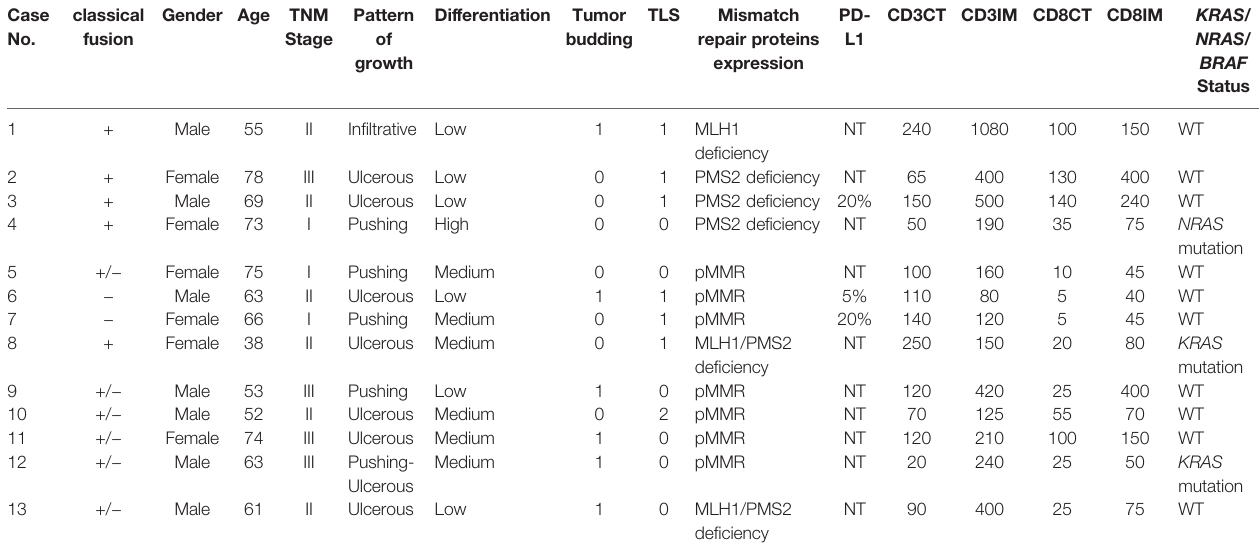
TABLE 3 | Clinical, pathological, immunological and molecular characteristics of 13 NTRKs fusion Positive CRCs. Case No.